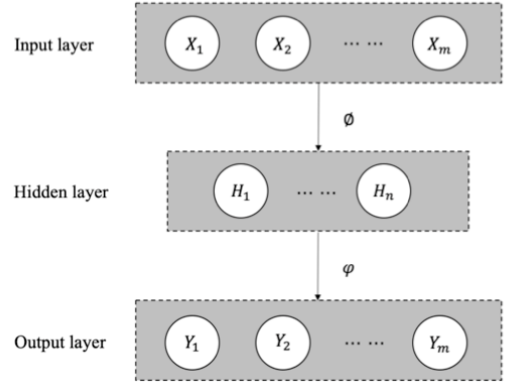
Figure 2. The autoencoder architecture (n < m).